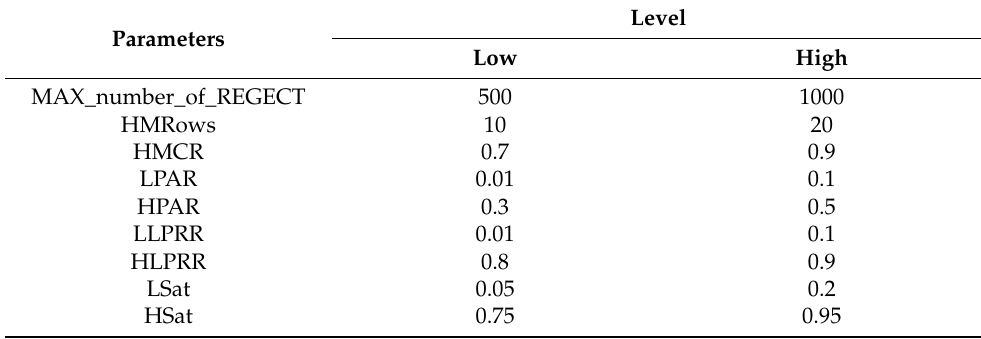
Table 5. MHS factors and their two levels.